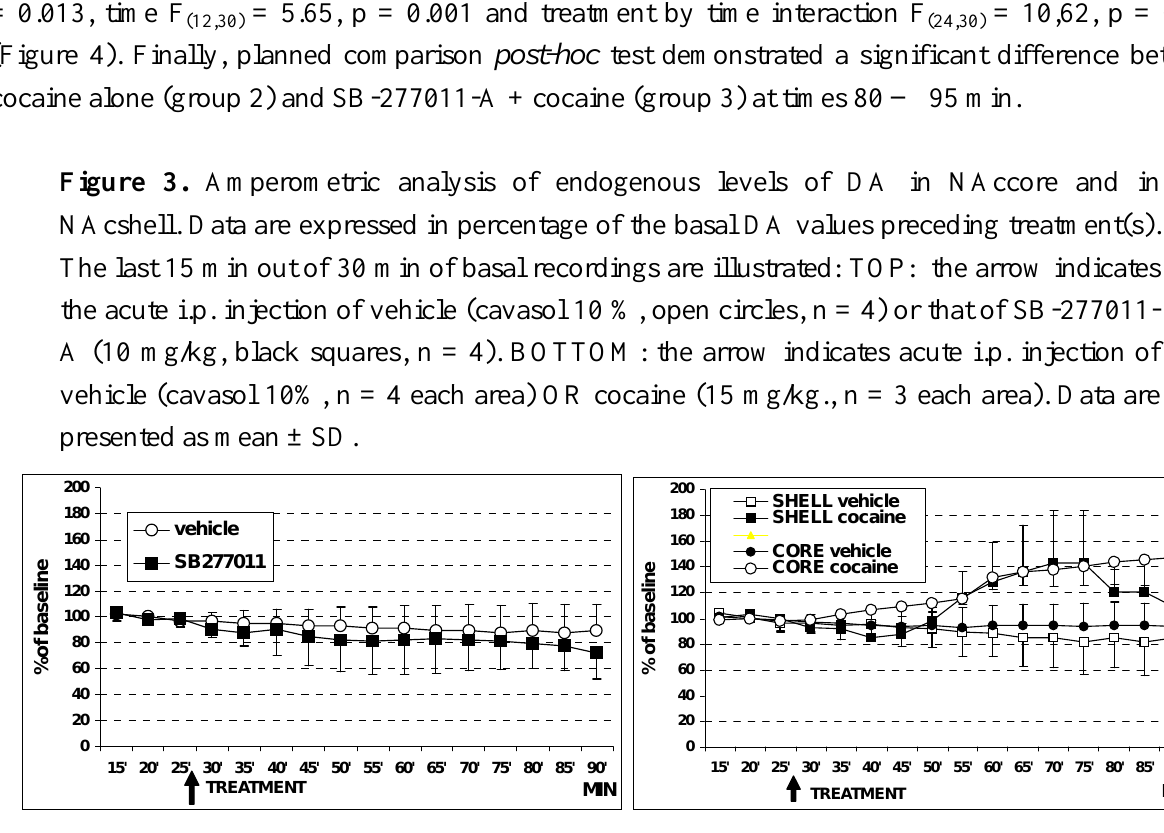
Figure 4. Amperometric analysis of endogenous levels of DA in NAccore and in NAcshell. The last 15 min out of 30 min of basal recordings are illustrated. Data are expressed in percentage of the basal DA values preceding treatment (arrow) i.e. cavasol 10 % (n=4), black triangles, cocaine 15 mg/kg. open squares (n= 3) or SB-277011-A 10 mg/kg + cocaine 15 mg/kg, black circles (n =